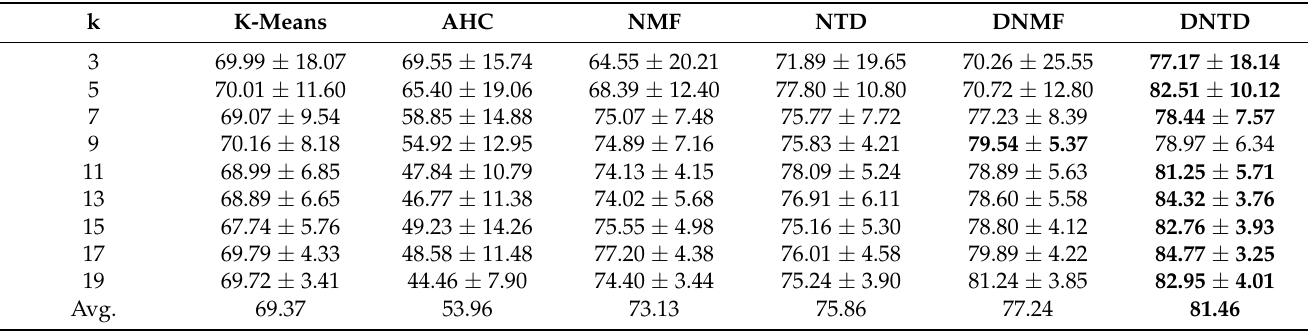
Table 2. NMI (%) ± standard deviation (%) of different algorithms on ORL dataset.